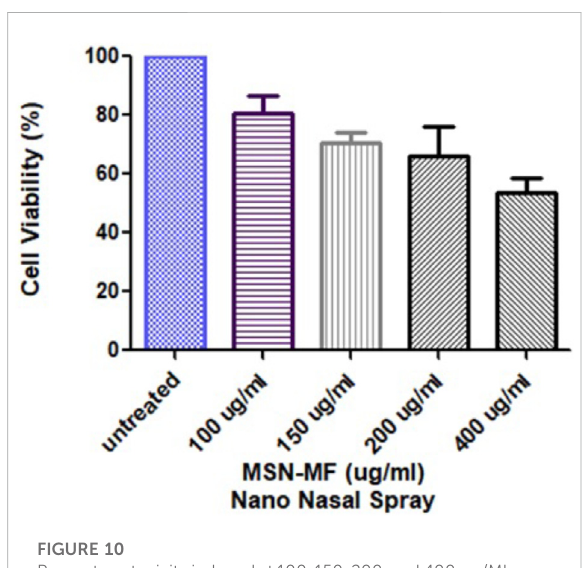
FIGURE 10 Percentagetoxicityinducedat100,150, 200,and 400 μ g/ML of MSN-MF nano-nasal